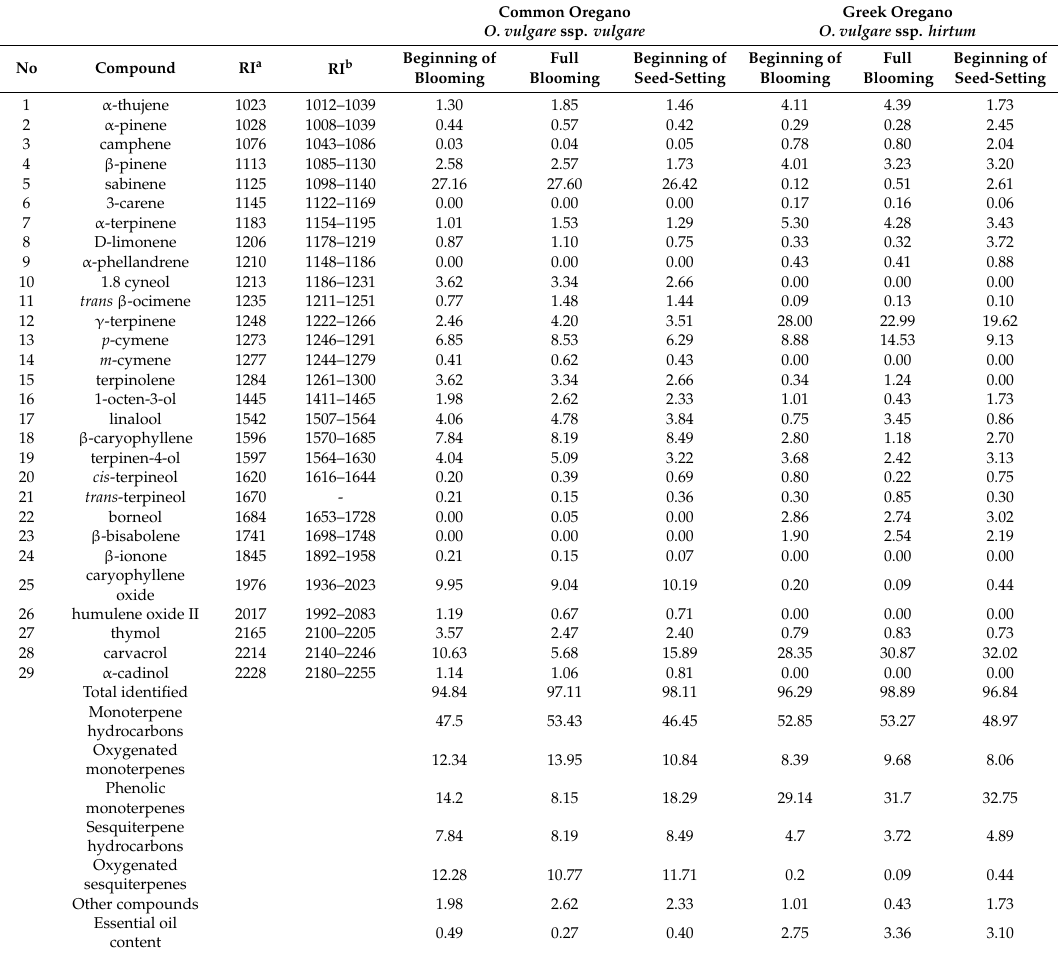
Table 5. The total content (g × 100 g − 1 DW) and gas chromatographic composition (% peak area) of essential oil